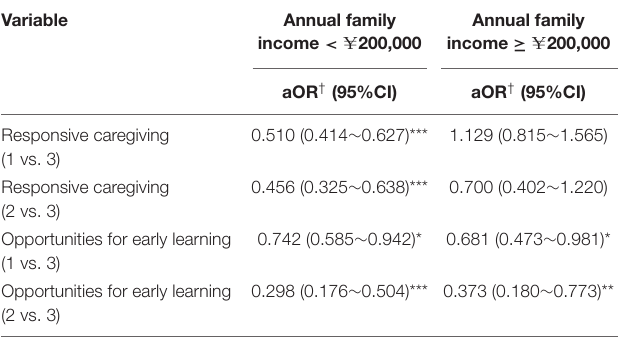
TABLE 3 | The relations between responsive caregiving or opportunities for early learning and development of infants in different income groups.